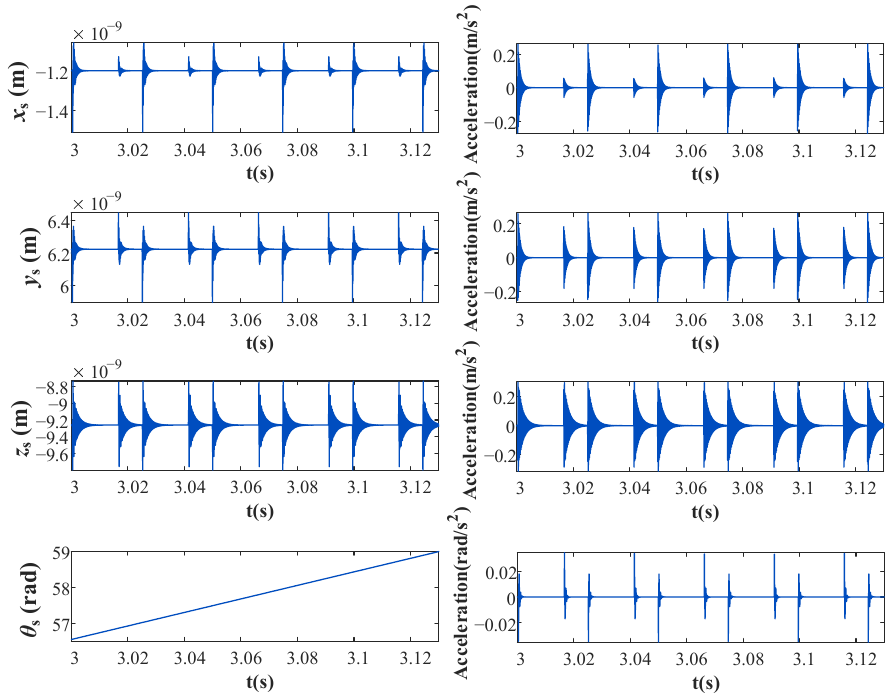
Figure 8. Displacement responses and acceleration responses of the screw-shaft-related parameters under normal conditions. When the angular velocity of the screw shaft is constant, θ s and θ m increase linearly, and the rotation of the screw shaft drives the nut to move axially, so the axial displacement of the nut ( z n ) also increases, as shown in Figure 9. However, affected by the impacts of the balls entering and exiting the return device, the value of z n fluctuates slightly with increased rotation of the screw shaft. Because the amplitude of the fluctuation is far less than the value of z n (at about 10 − 7 level), it is difficult to directly determine the impacts of balls in the displacement response of z n , although they are much more obvious in the ac- celeration response.